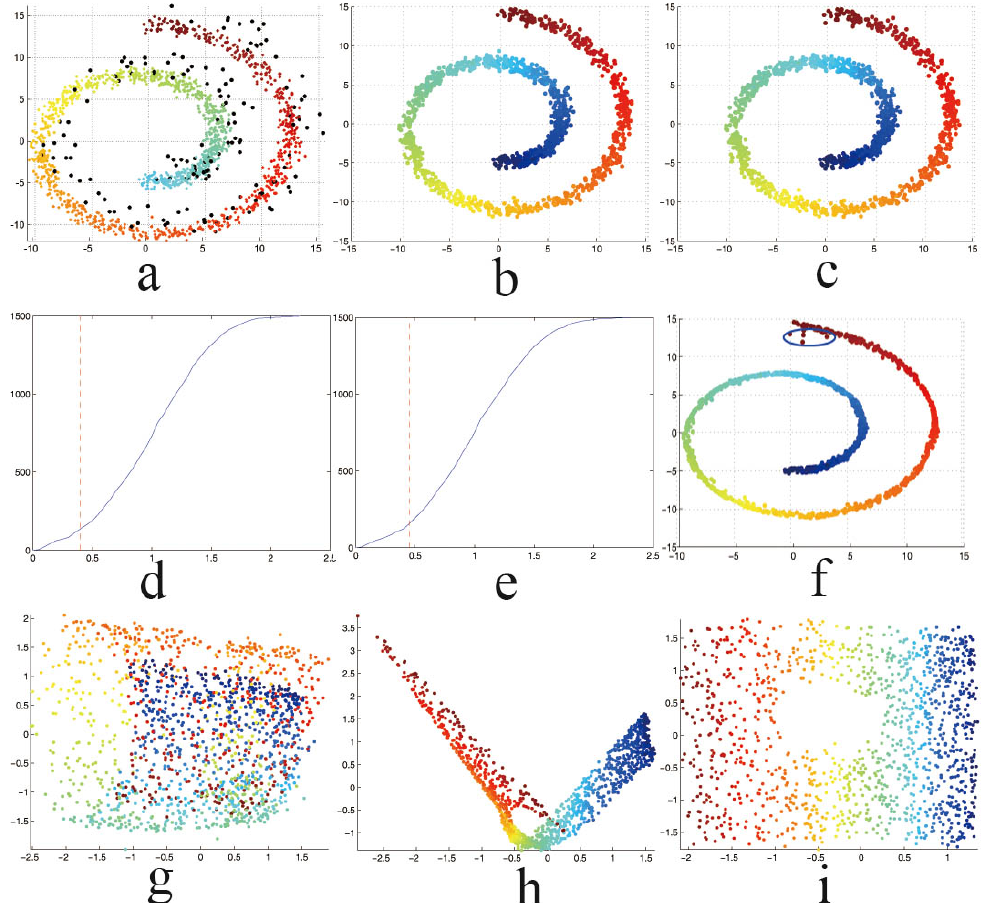
Figure 2. Results of HLLE, RLLE and RHLLE applied to the “Swiss roll with a hole” dataset with the existence of outliers and noises. ( a ) Dataset with outliers and noises; ( b ) Results of outlier removal using RLLE’s method; ( c ) Results of outlier removal using RHLLE’s method; ( d ) Cumulative distributions of reliability scores computed by the RLLE’s method; ( e ) Cumulative distributions of reliability scores computed by the RHLLE’s method; ( f ) Results of noise reduction with one iteration of local smoothing; ( g ) HLLE result; ( h ) RLLE result; ( i ) RHLLE